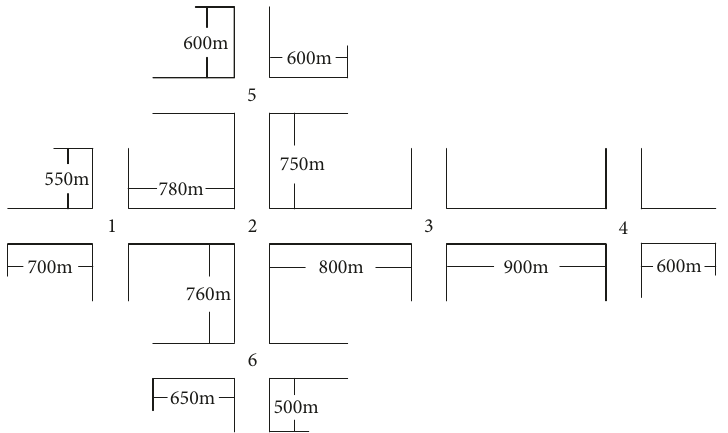
Figure 6: Schema of urban intersection